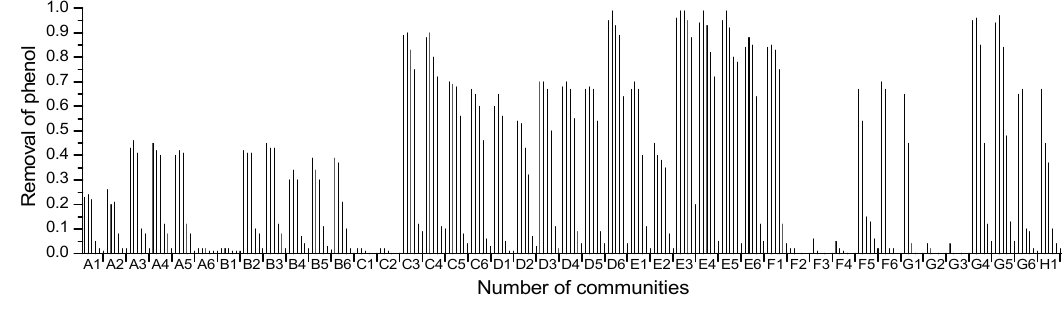
Figure 3. Results of high-throughput screening for halophilic bacterial phenol-degrading communities.